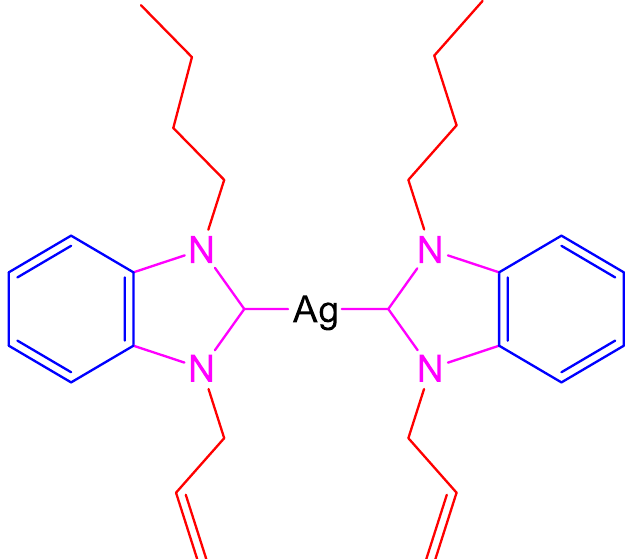
Figure 14. Bis (1-allyl-3-butyl-2,3-dihydro-1 H -benzo[ d ]imidazole-2-yl) silver complex.